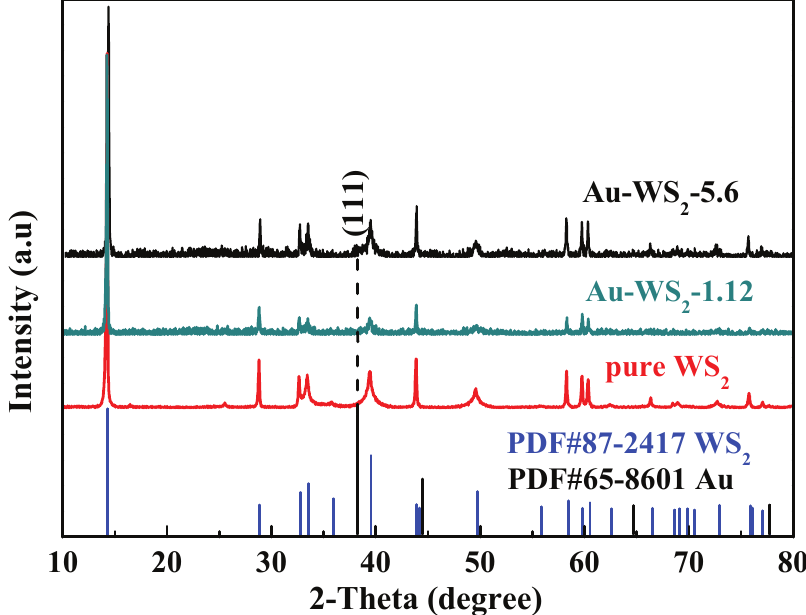
Figure 2. XRD patterns of pure WS 2 and Au/WS 2 based